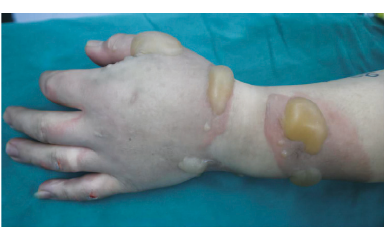
Figure 4: Prior treatment.